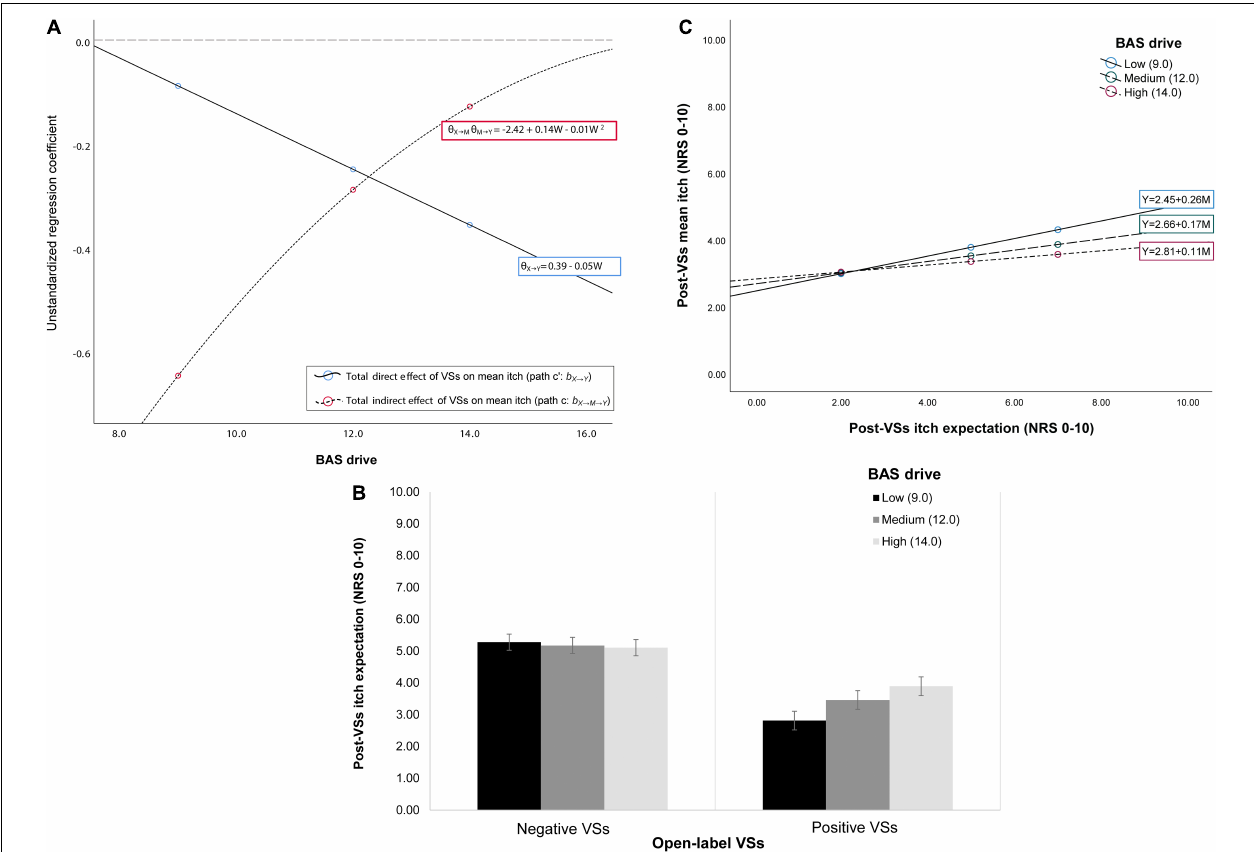
FIGURE 3 | Depiction of the conditional indirect and direct effects of VSs on mean itch across low, medium and high levels of behavioral activation system (BAS) trait drive for the open-label arms of studies 2–3. (A) There was moderated mediation (depicted in (A) as the change in unstandardized regression coefficient magnitude for the effects of VSs on mean itch for low, medium and high levels of the moderator): the indirect (i.e., expectation-mediated) effects of VSs on mean itch (path c) changed depending on the level of BAS drive (i.e., the motivation to achieve goals). The effects of VSs on mean itch were significantly mediated by expectations in case of low drive to achieve goals (i.e., when BAS drive scores were low). When participants had high drive to achieve their goals (i.e., when BAS drive scores were high), expectations did not mediate the association between VSs and mean itch; instead, the direct effects of VSs on itch (path ‘c) tended to be stronger. This moderated mediation can also be explained as follows: (B) positive VSs were associated with lower itch expectation compared to negative VSs when BAS drive was lower (significant BAS drive × VSs interaction; depicted in (B) as mean itch expectation ± SEM for low, medium and high BAS drive levels); and (C) the association between lower itch expectation and lower post-VSs mean itch was stronger at low compared to high levels of BAS drive (depicted in (C) as simple regression slopes for each level of the moderator).